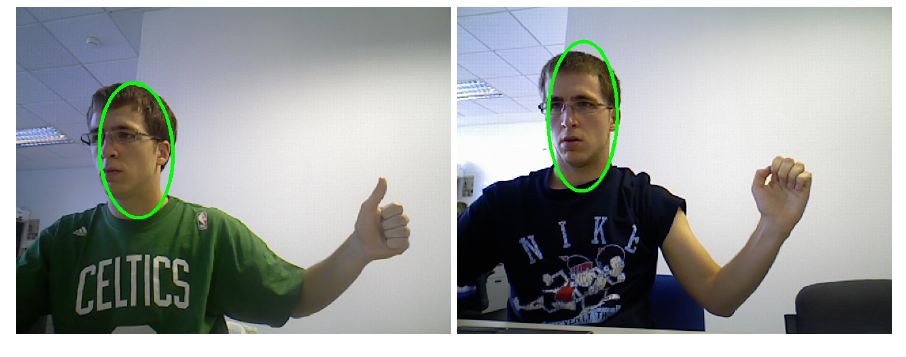
Figure 2. Skin region classification: Detection of blobs that correspond to human faces.